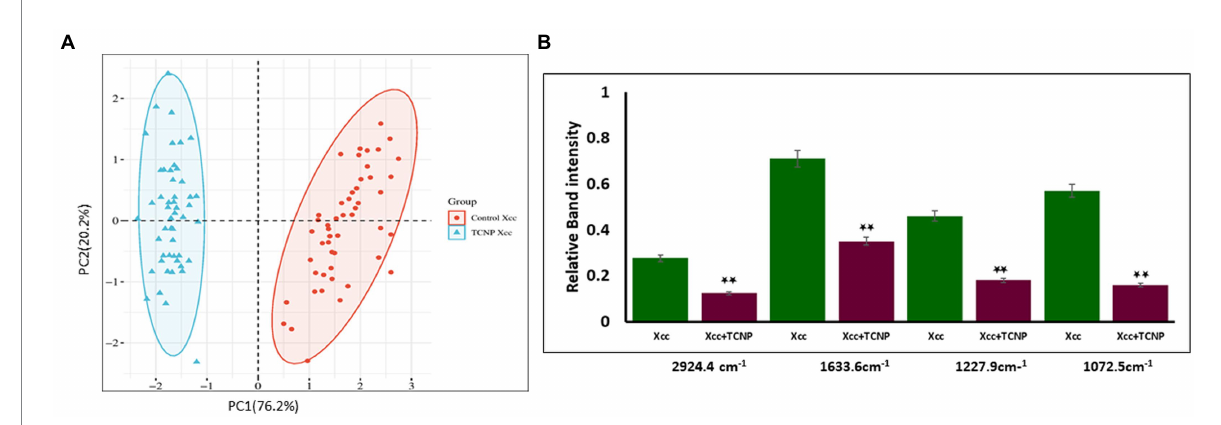
FIGURE 5 (A) PCA analysis of FTIR spectra. (A) PCS score plots showing distinct clustering between the control cells (Red dot) and treated Xcc cells (Blue dot). (B) Relative band intensities at the peak 2924 cm -1 , 1633 cm -1 , 1227 cm -1 , and 1072 cm -1 are represented as mean ± S.D. of three independent experiments, each performed in triplicates and considered statistically significant when * p < 0.05.